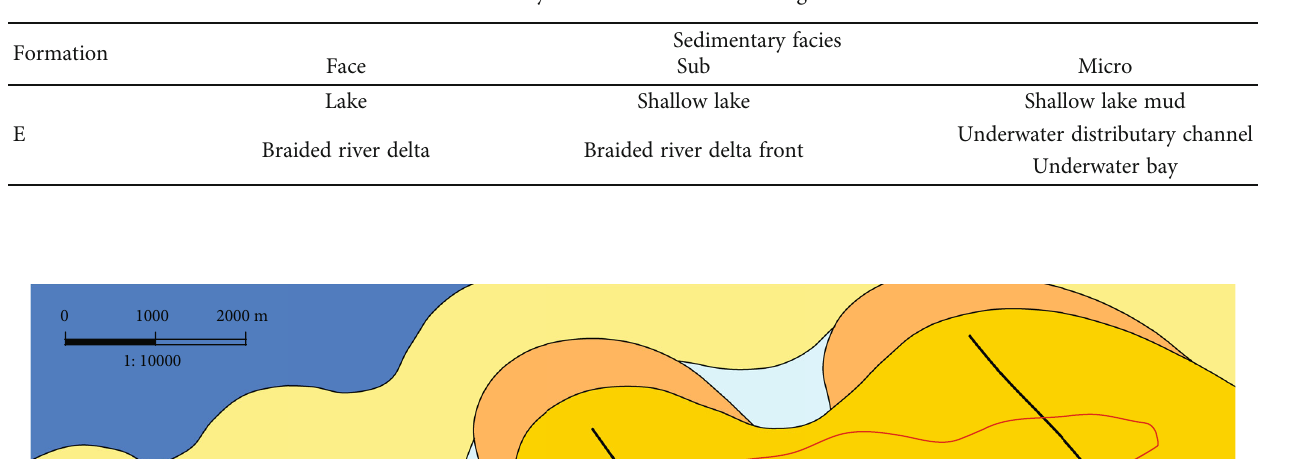
Table 2: Sedimentary microfacies division of Yingmai 7